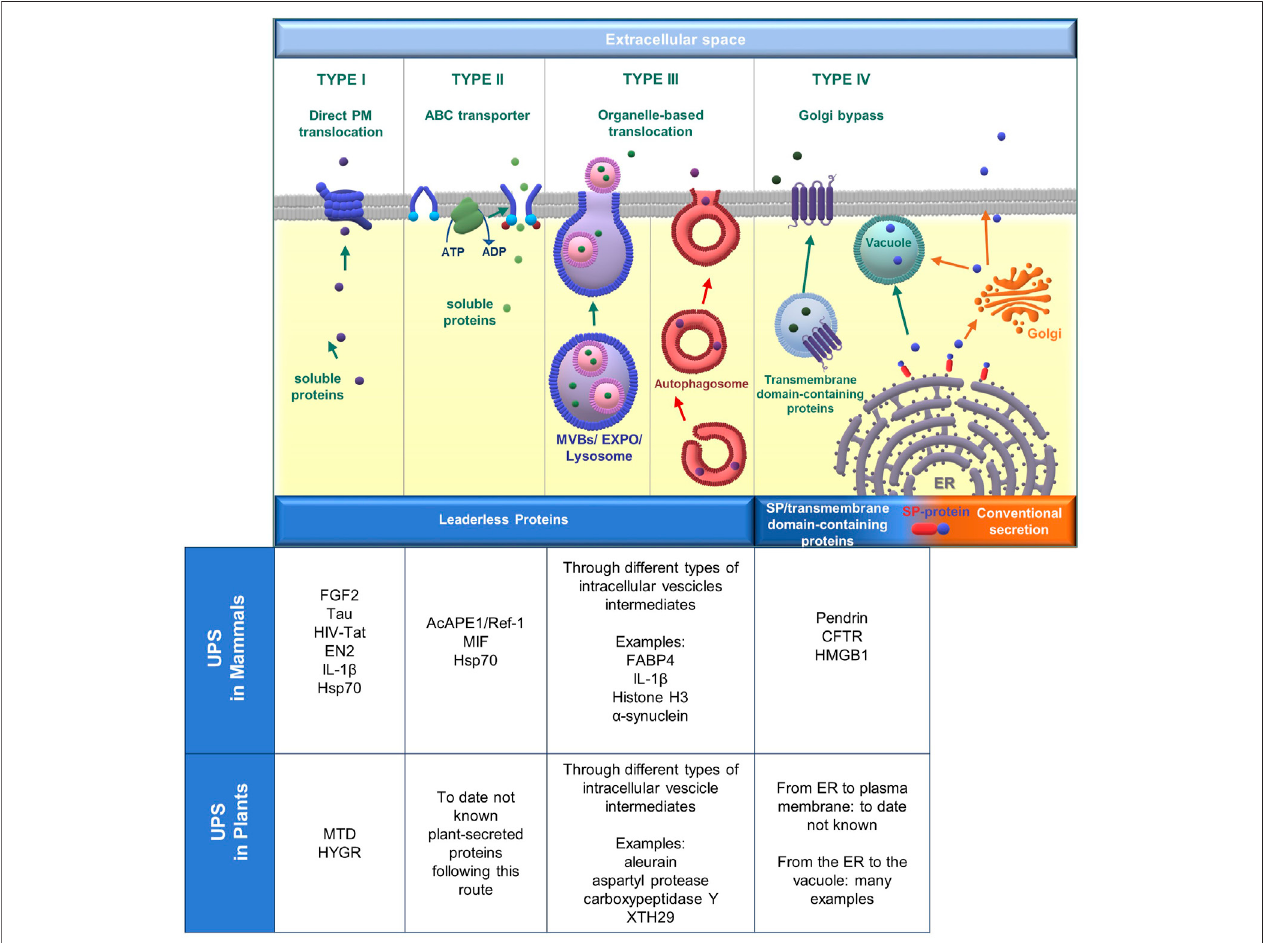
FIGURE 1 | Overview of unconventional protein secretion (UPS) pathways in mammals and plants, with a description of proteins following different UPS routes. From left toright: UPS type I,UPS type II,and UPS type III areused byleaderless proteins whichemploy different methods togothrough theplasmamembrane (PM). In type III autophagosomes are inserted torepresent the crosstalk between UPS and autophagy (see Paragraph 1.1.3). The scheme ofUPS type IV represents the destiny of SP/transmembrane domain-containing proteins translocated in the ER, the next journey to the plasma membrane in mammals, and the direct delivery to the vacuole in plants. However, such proteins normally traf fi c along the conventional secretory pathway and transit through the Golgi apparatus.